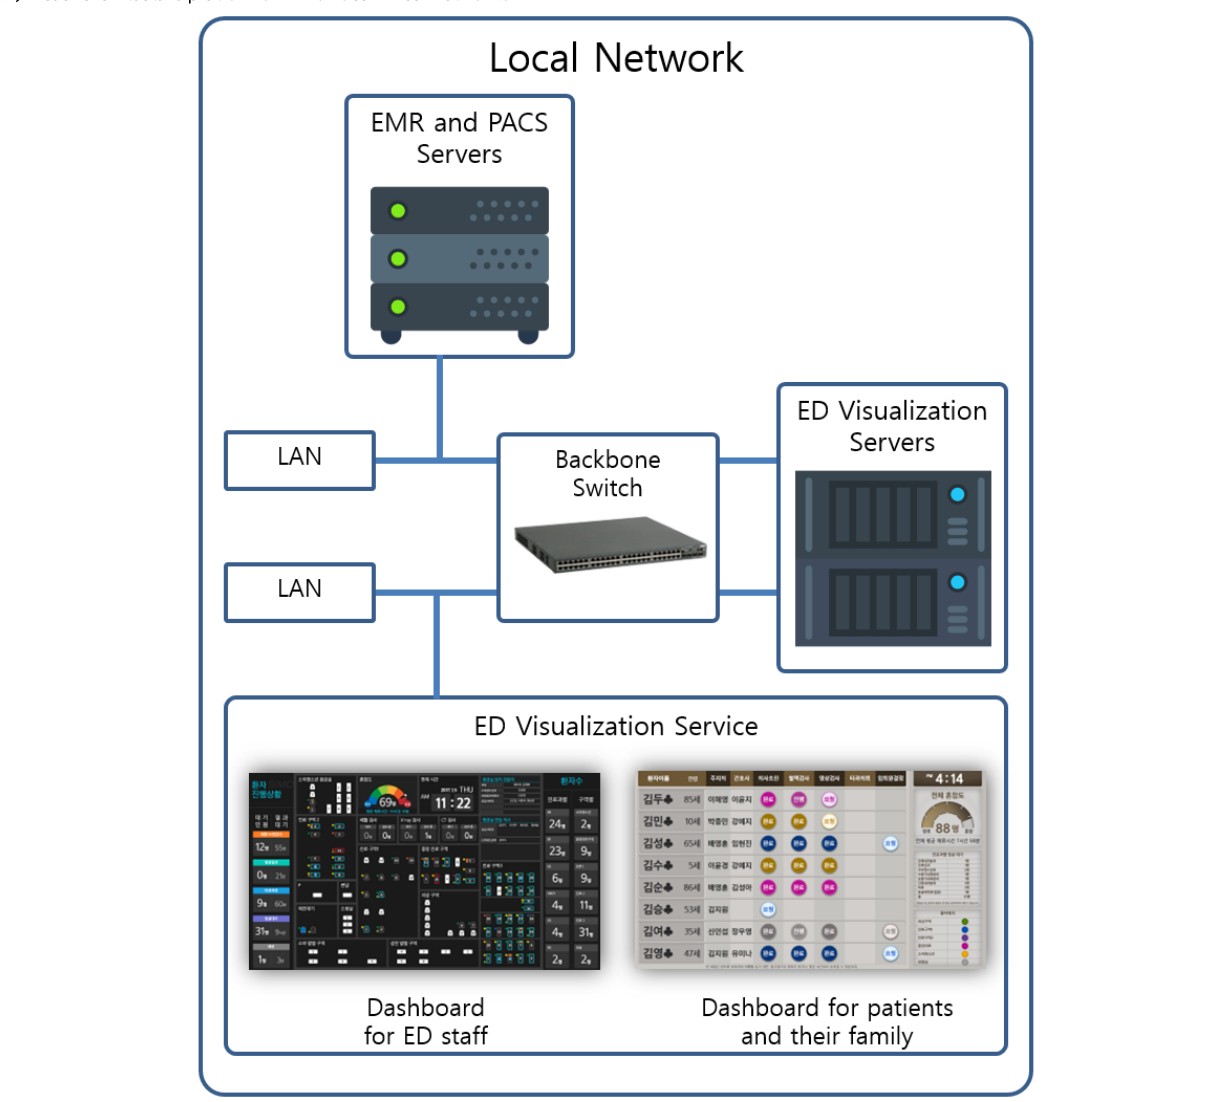
Figure 2. Transfer of electronic medical record (EMR) and picture archiving and communication system (PACS) data to the emergency department (ED) visual architecture platform. LAN: Local Area